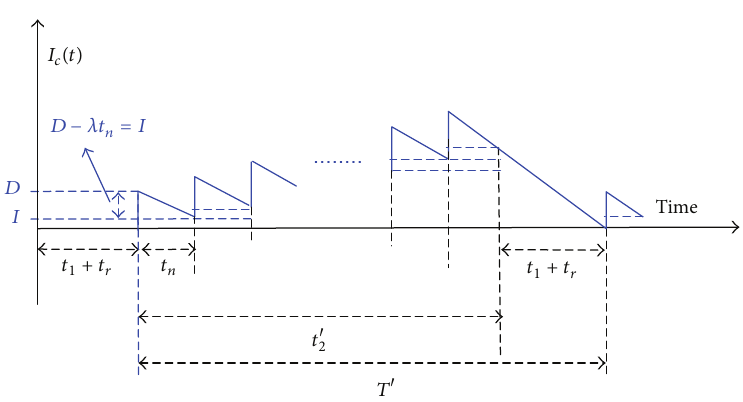
Figure 5: Inventory level of finished products on the retailer’s side in the proposed manufacturing run time problem with breakdown.